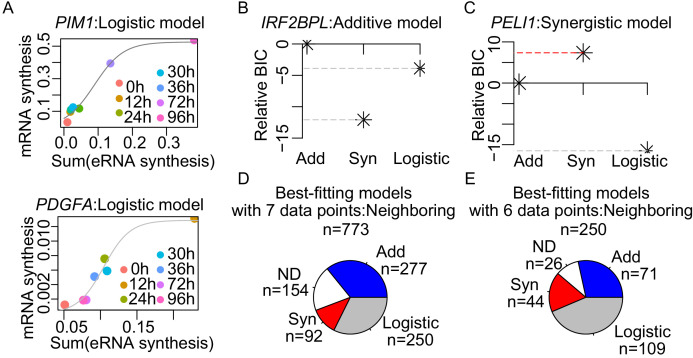
Enhancer cooperation can be additive or synergistic.(A) The observed normalized TT-seq RNA synthesis level for the indicated mRNA and the sum of the paired eRNAs were plotted for PIM1 and PDGFA, those best-fitted with a logistic model as shown with curve fits (gray line). (B and C) The relative Bayesian Information Criterion (BIC) reveals that RNA synthesis follows either the additive (B) or the synergistic model (C). A higher relative BIC indicates better fitting of the model. (D) Using the neighboring pairing method, each of the tested genes was assigned to three theoretical models according to the BIC with seven data points. Numbers of the genes assigned with the indicated models are depicted. (E) Using the neighboring pairing method, BIC of the genes that were best fitted with logistic model were recalculated with six data points, without the data point with the highest sum of enhancer activities. Number of the genes assigned with the indicated models according to BIC is depicted.